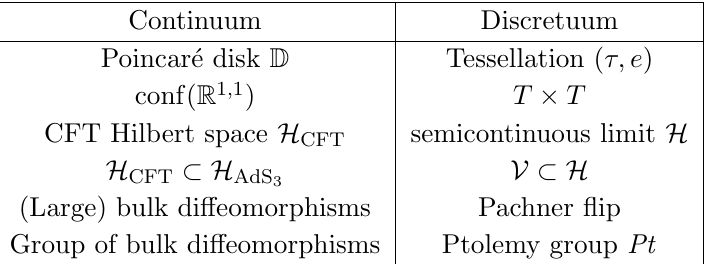
Figure 25 . The hexagonal tiling f 6 ; 4 g with a wedge cut out. The two geodesic segments marked by arrows are identi(cid:12)ed. We propose this as a model for a massive particle solution.